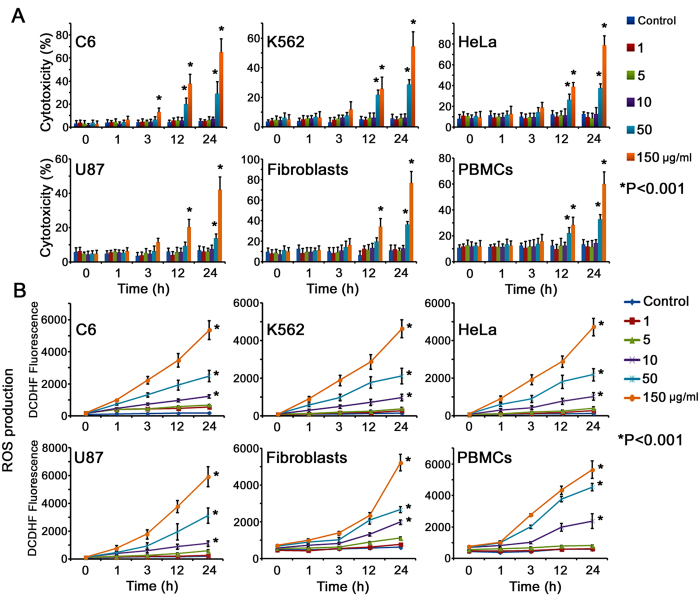
Cytotoxicity analysis of the Fe(0) @ MCM-41 particles.(A) Cytotoxicity assay of the tumor and normal cells incubated with particles. Each value represents mean ± S.D. from three independent experiments. (B) Kinetics of ROS production following cells exposure to MSNs and Fe-MSNs. Each value represents mean ± S.D. from four independent experiments.